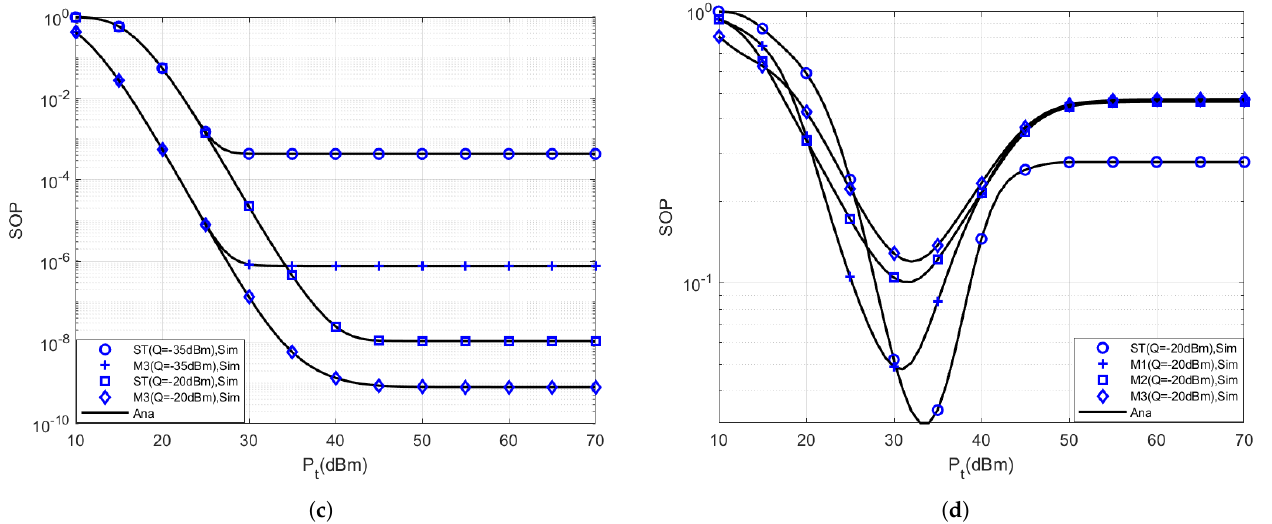
Figure 3. The secrecy outage performance of secondary users with various TAS schemes and interfer- ence temperature. ( a ) SOP of U 1 ; ( b ) SOP of U 2 ; ( c ) SOP of U 3 ; and ( d ) overall SOP.